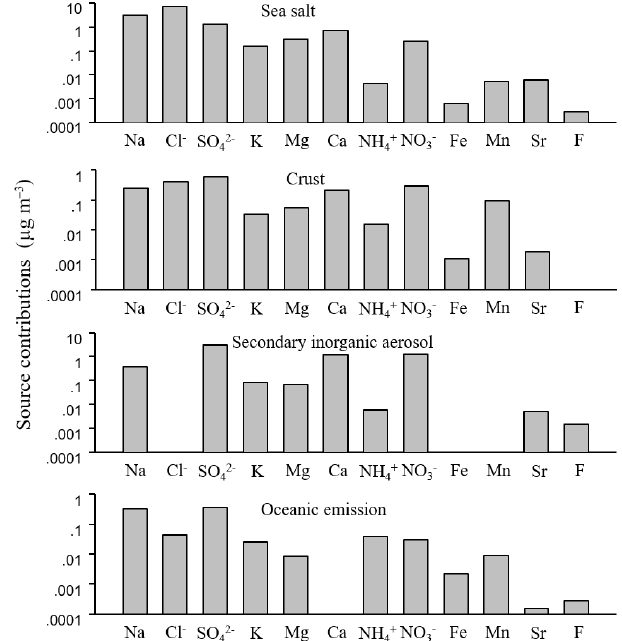
Figure 9. Profiles of five sources identified from the PMF 5.0 model, including sea salt (two species), crust, secondary inorganic aerosol and oceanic emission.